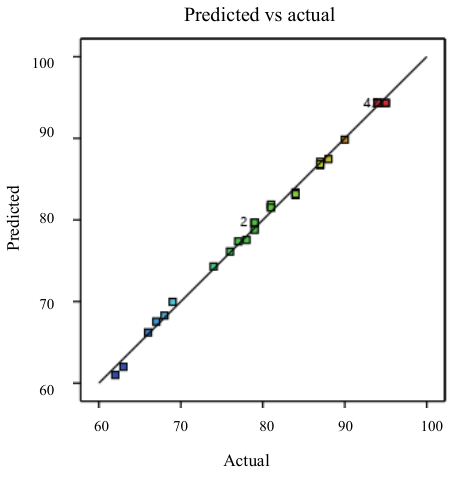
Fig. 2. Predicted yield versus actual biodiesel